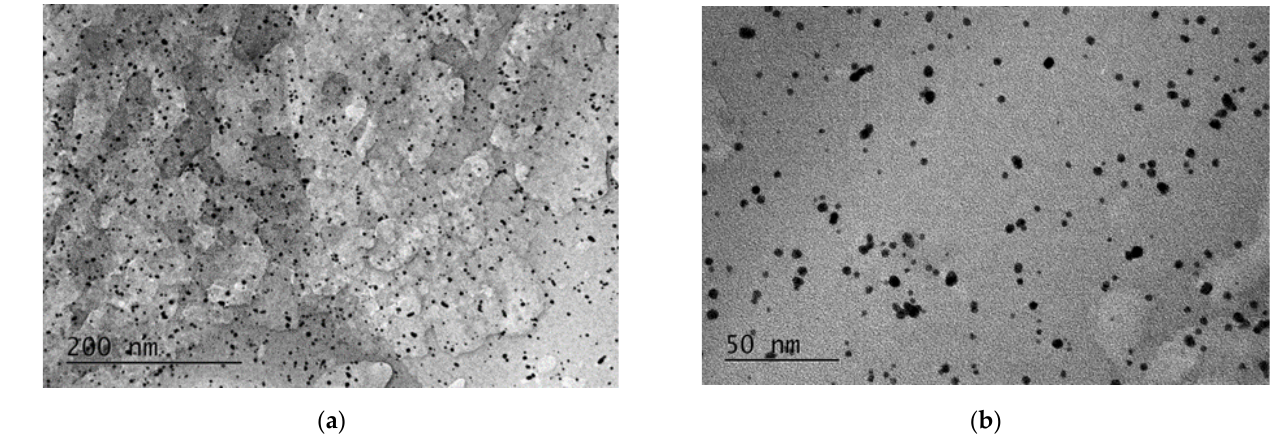
Figure 4. TEM micrographs at different magnifications ( a , b ) of Cr(III)-IIM.